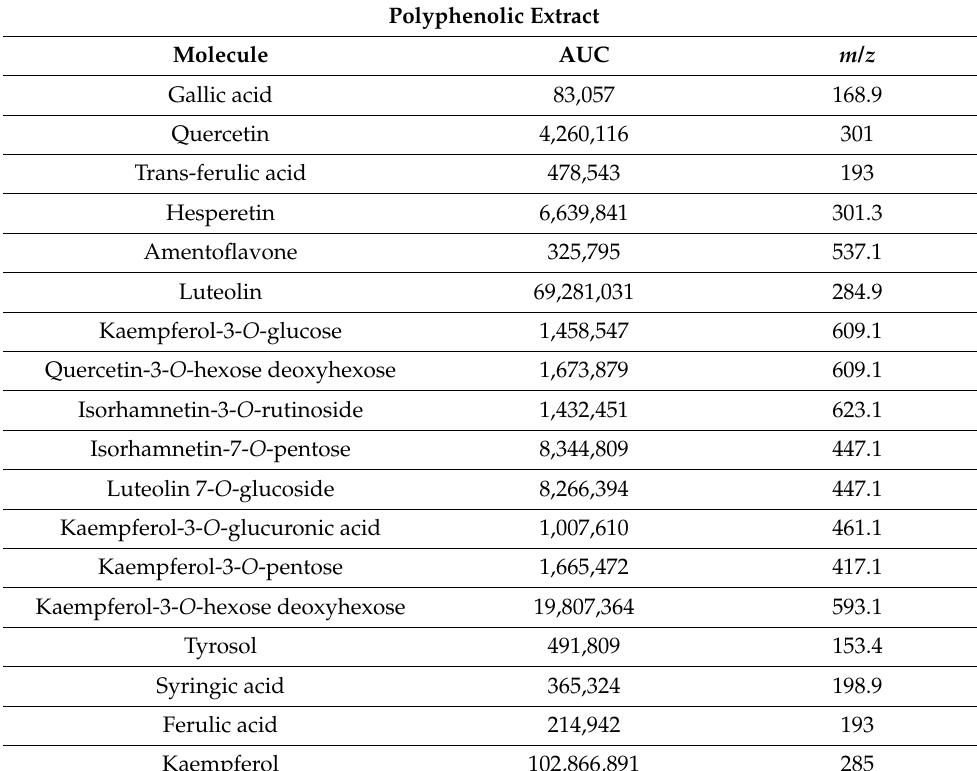
Table 1. Phenolic compounds identified in the C. europaea polyphenolic extract.